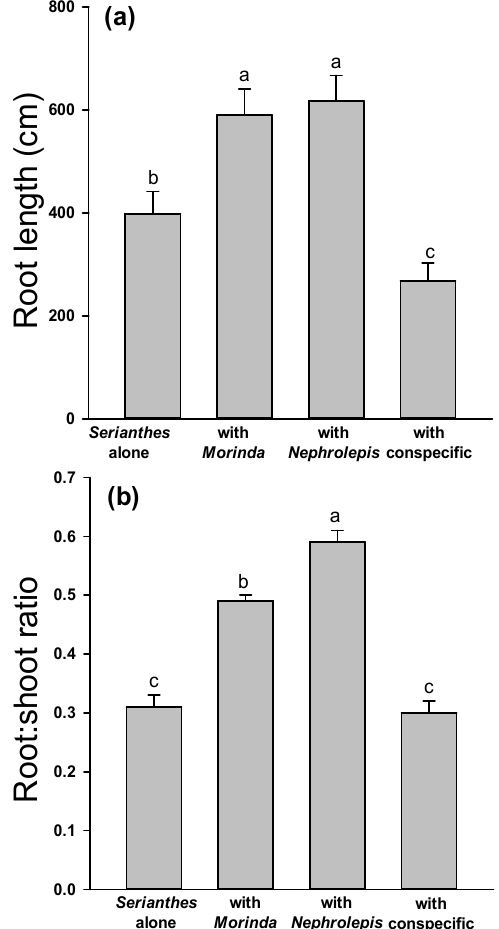
Figure 2. ( a ) Root length and ( b ) root:shoot ratios of Serianthes grandiflora seedlings grown with different species. Treatments were: Control, no companion; Morinda citrifolia; Nephrolepis hirsutula ; Conspecific. Root:shoot ratios based on dry weight. Bars represent one SE ( n = 8) and bars with the same letters are not significantly different.